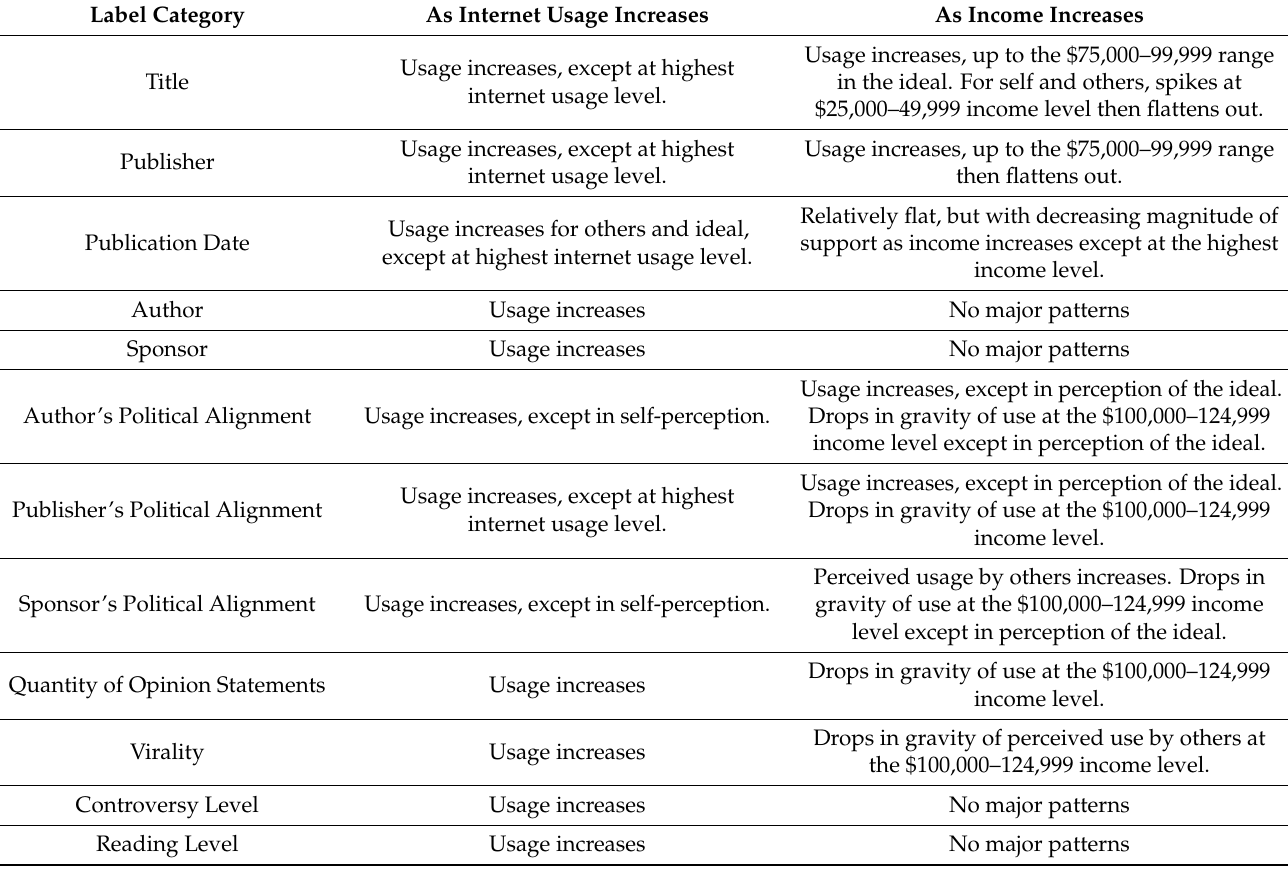
Table 7. Changes in usage levels of label categories as Internet usage and income levels